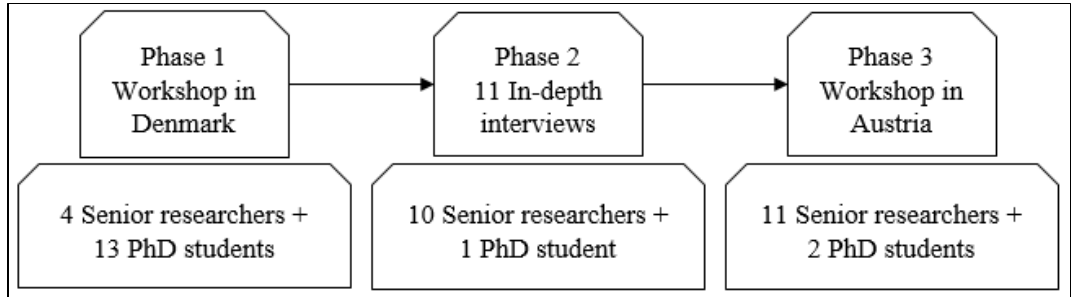
Table 1. Interviewee characteristics.